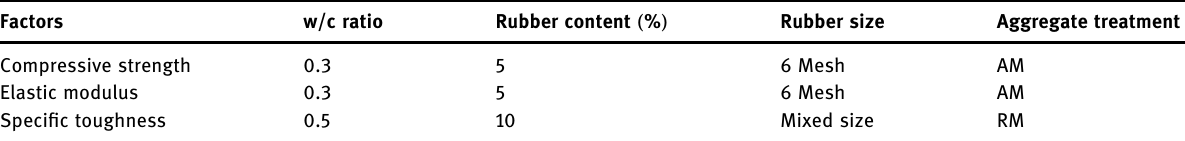
Table 11: Optimal level of the orthogonal factors Factors w/c ratio Rubber content ( % ) Rubber size Aggregate